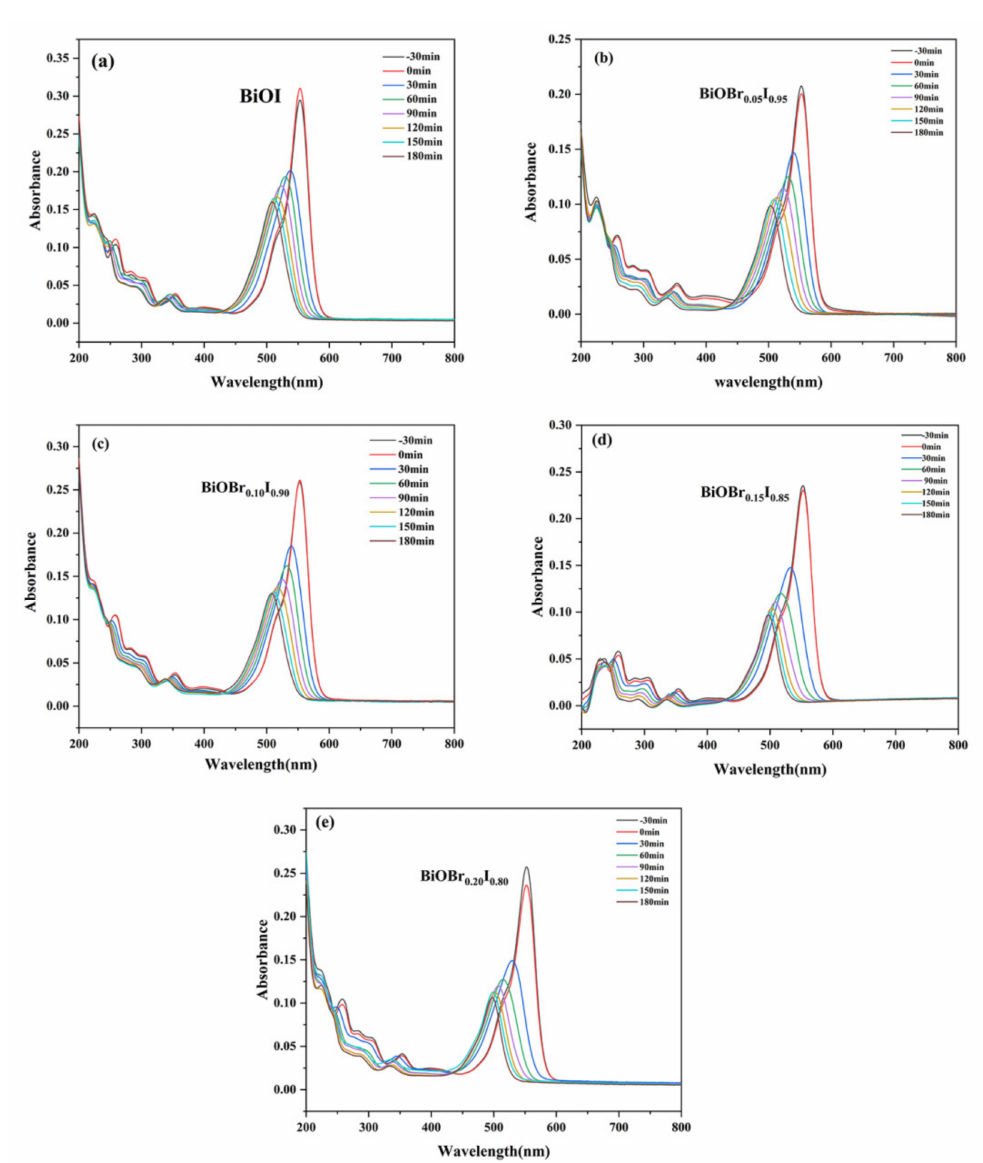
Figure 8. Temporal evolution of the spectra during the photodegradation of RhB mediated by the BiOBr X I 1 − X (( a ) x = 0.00, ( b ) 0.05, ( c ) 0.10, ( d ) 0.15, ( e ) 0.20)